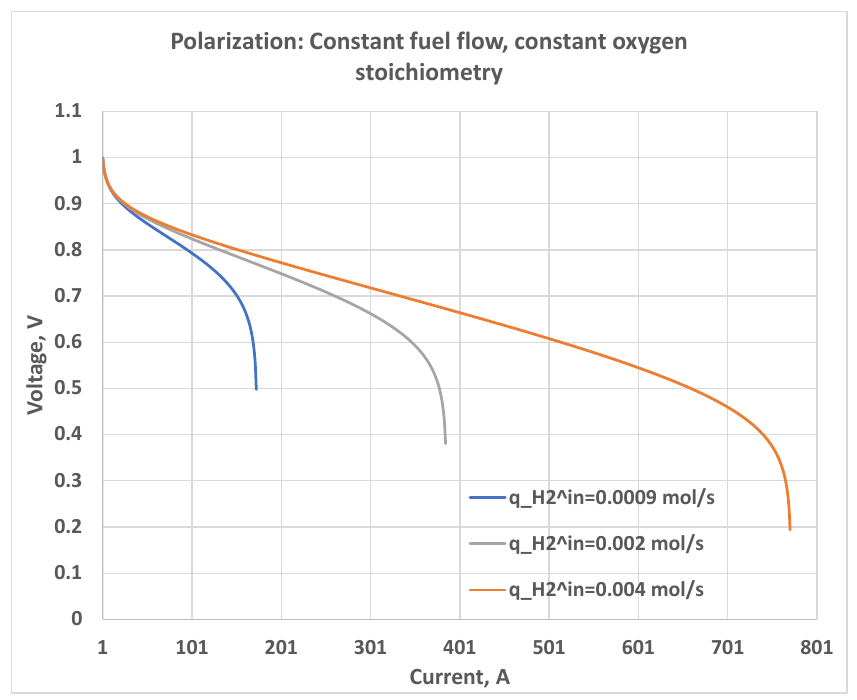
Figure 12. Effect of the hydrogen flow rate on polarization (constant hydrogen flow and constant oxygen stochiometry).